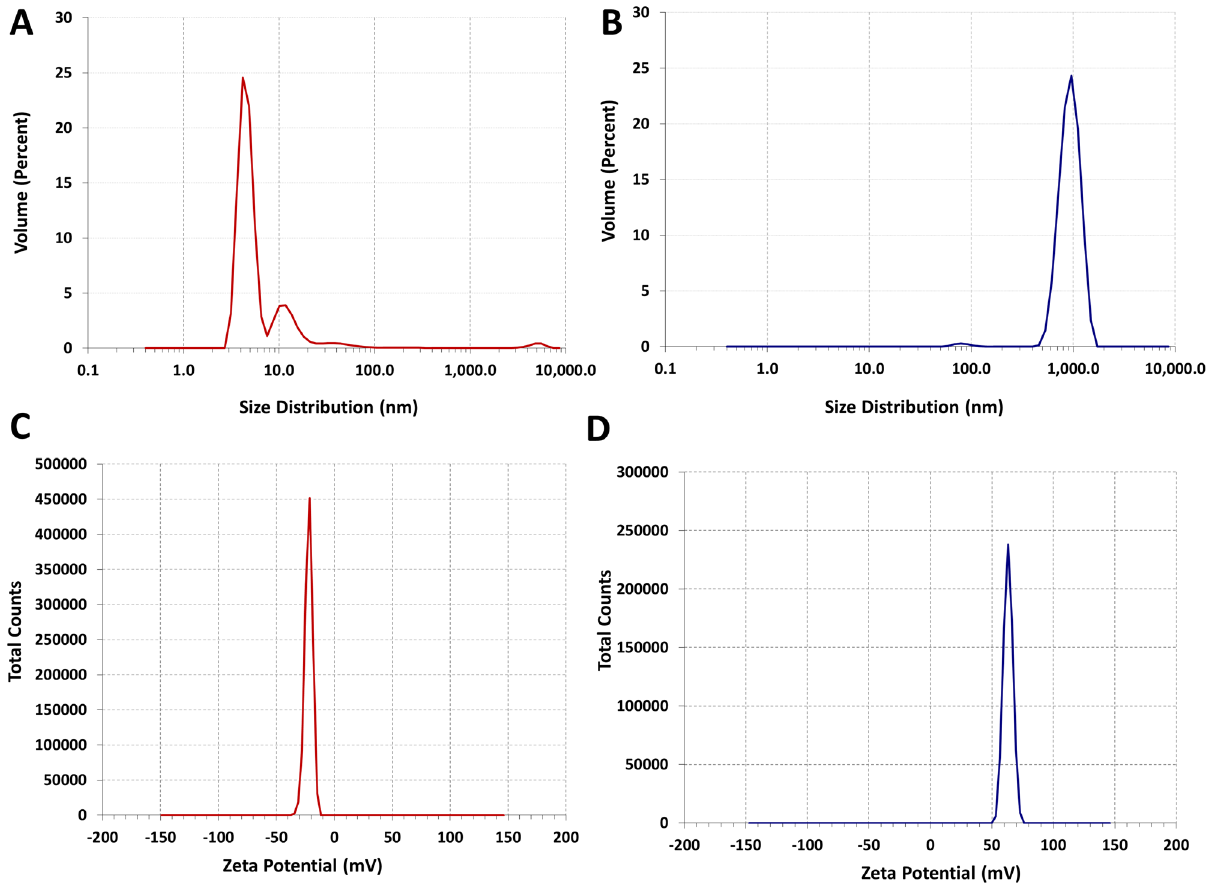
Figure 5. Average particle size distribution and surface charge values of the developed nanomaterials. ( a , b ) particle size distribution of silver nanoparticles (AgNPs) and silver nanocomposite system (AgCNCs) estimated using dynamic light scattering, respectively. ( c ) and ( d ) zeta potential values of silver nanoparticles (AgNPs) and silver nanocomposite system (AgCNCs) calculated using dynamic light scattering, respectively.